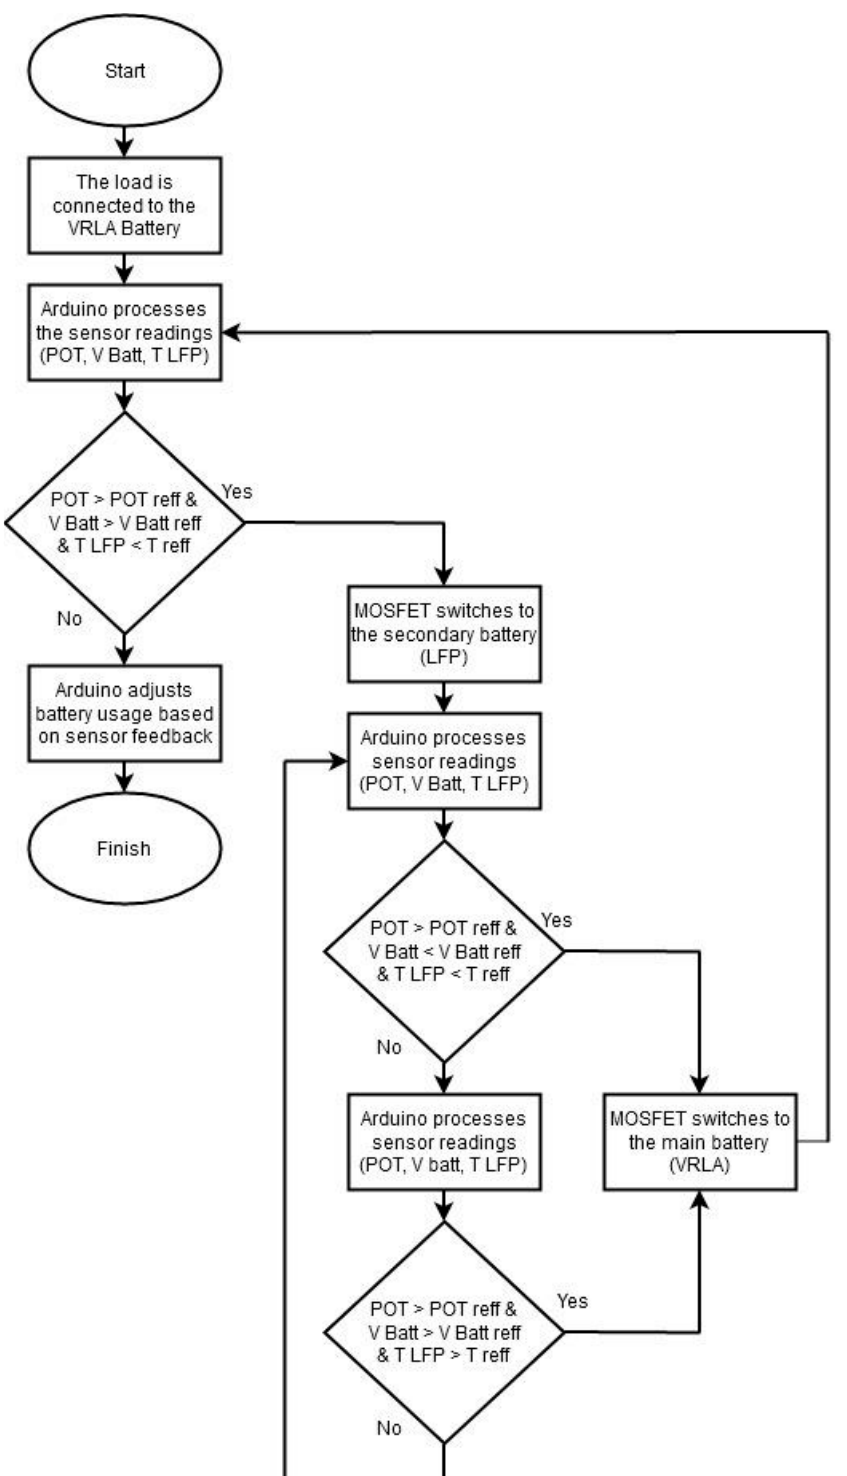
Figure 8. Flowchart of switching algorithm between two batteries.